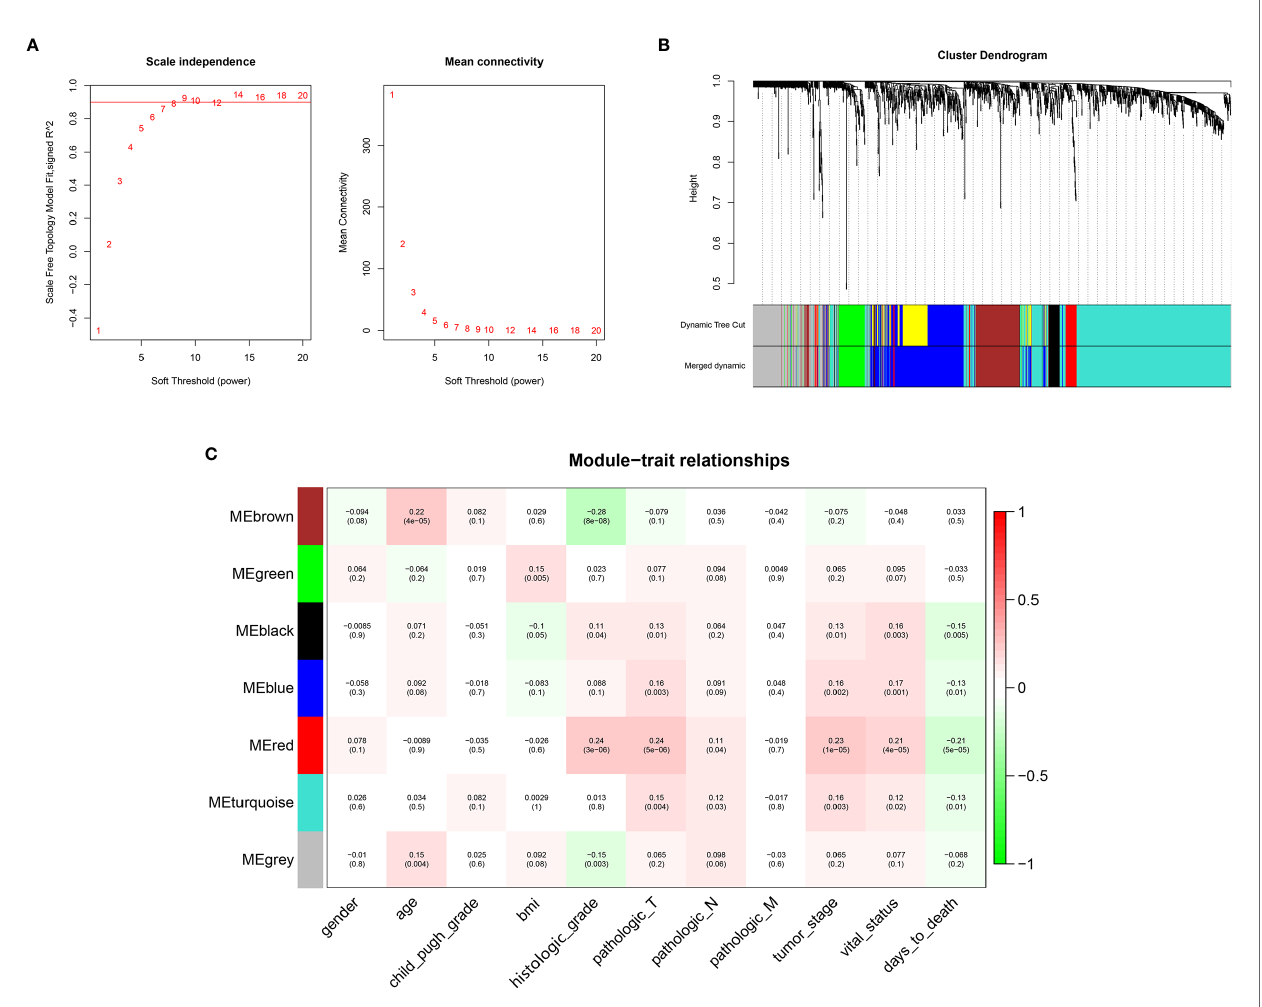
FIGURE 2 | WGCNA network and module detection. (A) Selection of the soft-thresholding powers. Power 8 was chosen because the fi tted index curve fl attened out upon reaching a high value (>0.9). (B) Cluster dendrogram and module assignment for modules from WGCNA. The colored horizontal bar represents the modules. (C) Correlation matrix for Eigengene values and clinical features. Each cell includes the corresponding correlations and the p